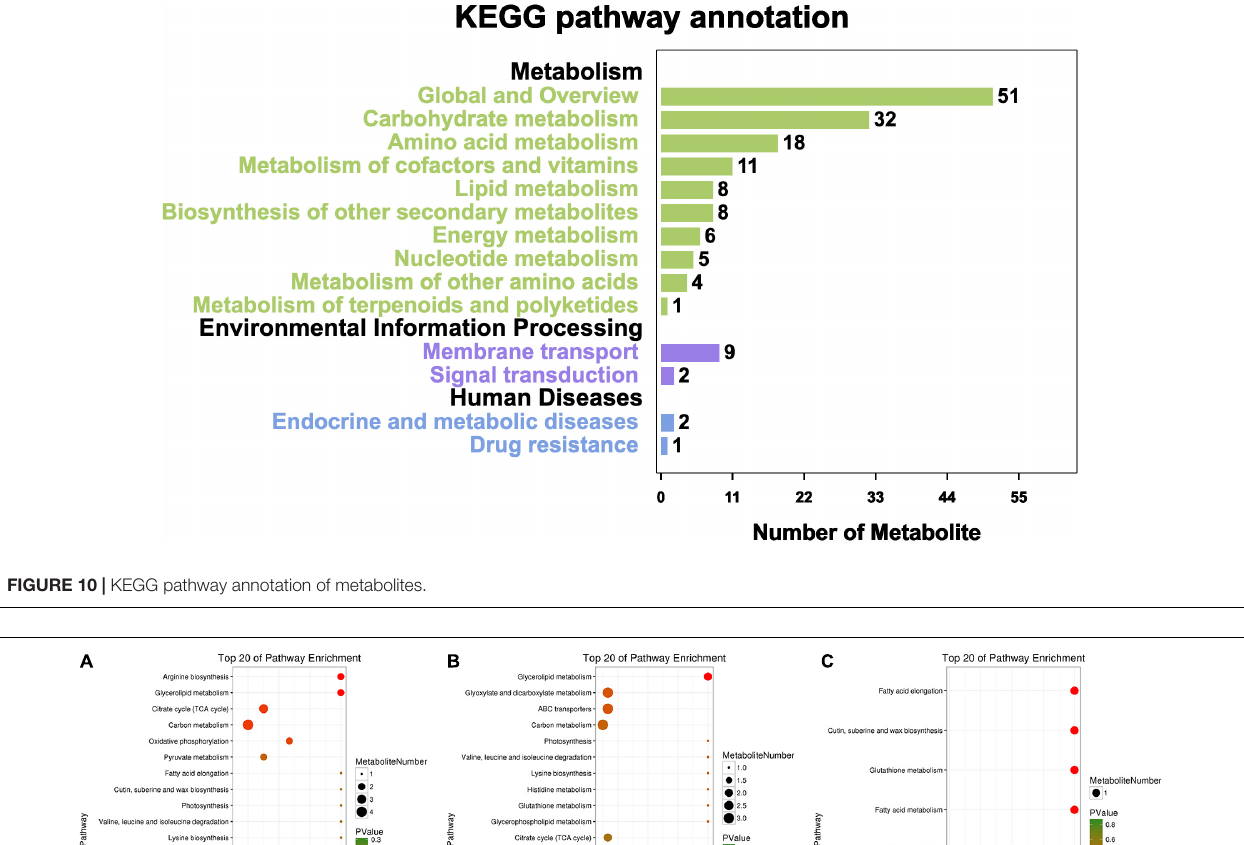
FIGURE 11 | Enriched KO pathway bubble diagrams. (A) Shows the enrichment of KO pathways in leaves and flower buds, and (B) shows the main KO pathways in which metabolites in leaves and blooming flowers are enriched. (C) Shows the enrichment of KO pathway in flower buds and blooming flowers. The top 20 Pathways with the smallest P value (or Q value) were used for mapping. The ordinate was Pathway, and the abscissa was enrichment factor (the number of differences in this pathway divided by all numbers). The size represented the number, and the redder the color, the smaller the P/Q